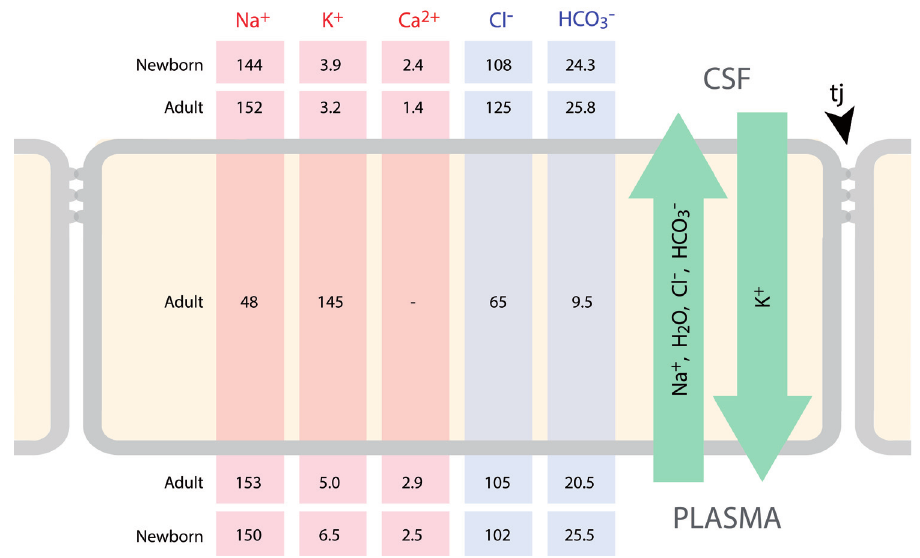
Figure 3. Ion gradients between CSF and plasma in developing and adult rat brain. A characteristic of CSF is its stable ionic composition that differs from that of plasma to an extent that cannot be explained by ultrafiltration, as was once thought 24 . Data for CSF and plasma (m-equiv/L water) are from 103 and for intracellular ions (mmol/L water) from Figure 8 in 104. The gradients are the consequence of the complex interactions between enzymes (notably carbonic anhydrase) ion transporters and ion channels, as illustrated in Figure 2. The CSF secretion rate in the embryo and newborn is much lower than in the adult 105–107 , which is perhaps explained by the much lower expression of carbonic anhydrase and ATPases in the developing choroid plexus.